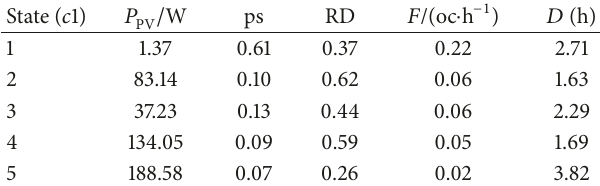
Table 2: Markov model of PV/200 W.